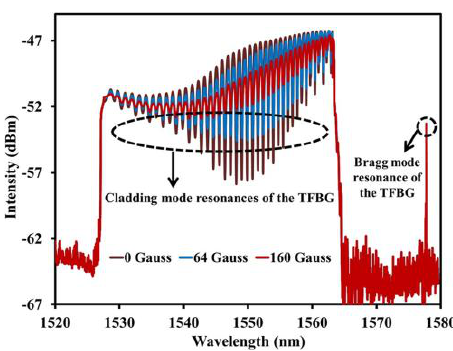
Figure 6. Experimental setup for the magnetic field measurement based on a CFBG-cascaded TFBG (adapted from [39]).